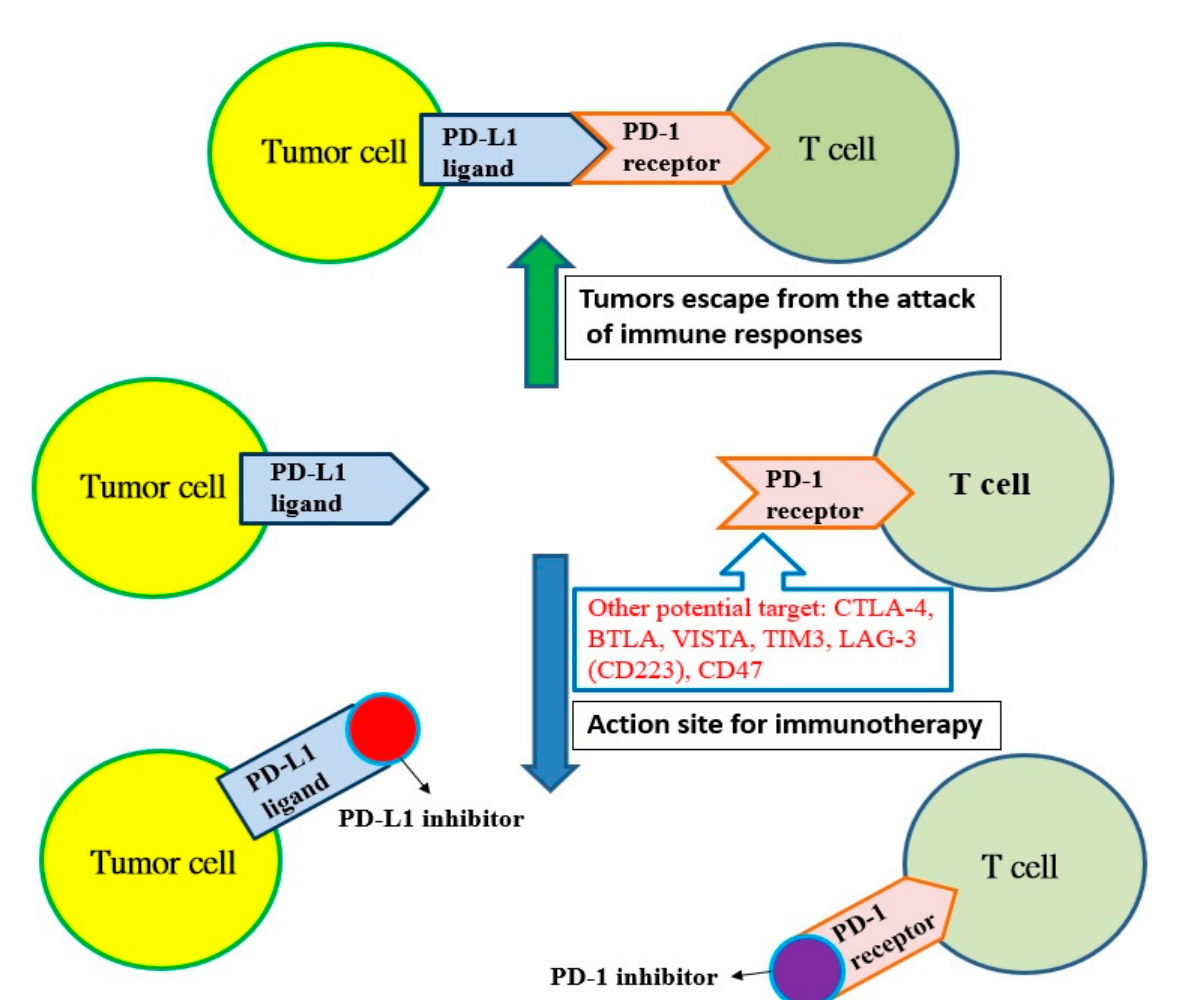
Figure 1. The programmed cell death protein ligand 1 (PD-L1) of tumor cells binds with the programmed cell death protein 1 (PD-1) receptor on T cells, and tumors escape from the attack of immune responses. However, T cells can recognize tumor cells and initiate immunotherapy if the PD-1 receptor is blocked by the PD-1 inhibitor or the PD-1 ligand is blocked with the PD-L1 inhibitor. Other potential targets: cytotoxic T lymphocyte-associated antigen 4 (CTLA-4); B and T lymphocyte attenuator (BTLA); variable domain immunoglobin suppressor of T cell activation (VISTA); T cell immunoglobulin and mucin-containing protein 3 (TIM3); lymphocyte-activated gene-3 (LAG-3, CD223); CD47. Table 1. The monoclonal antibodies approved by the U.S. FDA to be used as immune checkpoint inhibitor for immuno- therapy related to lung cancer or colorectal cancer.